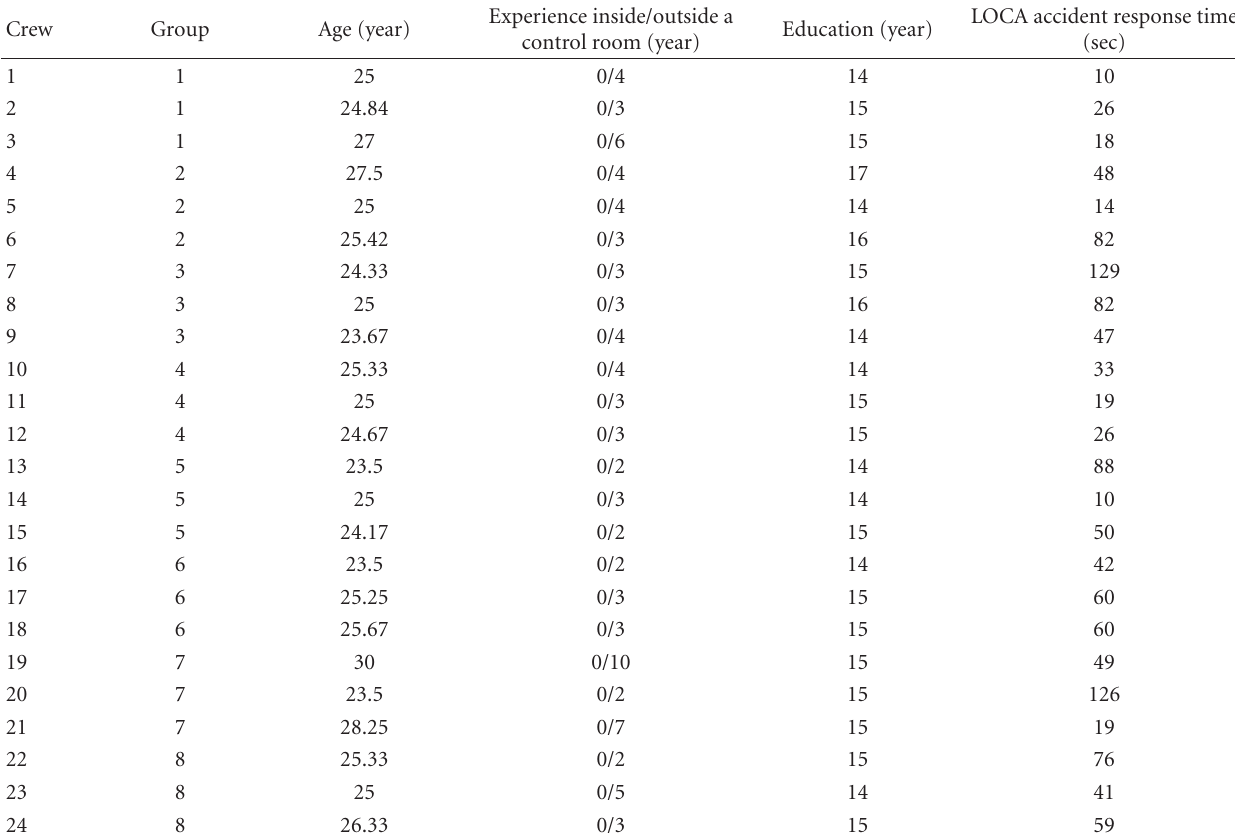
Table 1: LOCA accident experimental result and the Chinese NPP operators data.